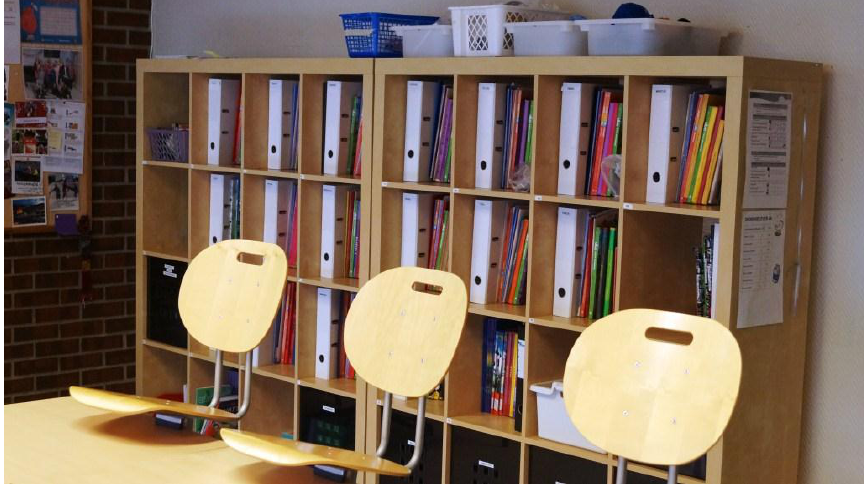
Figure 2. 5S System in a Classroom